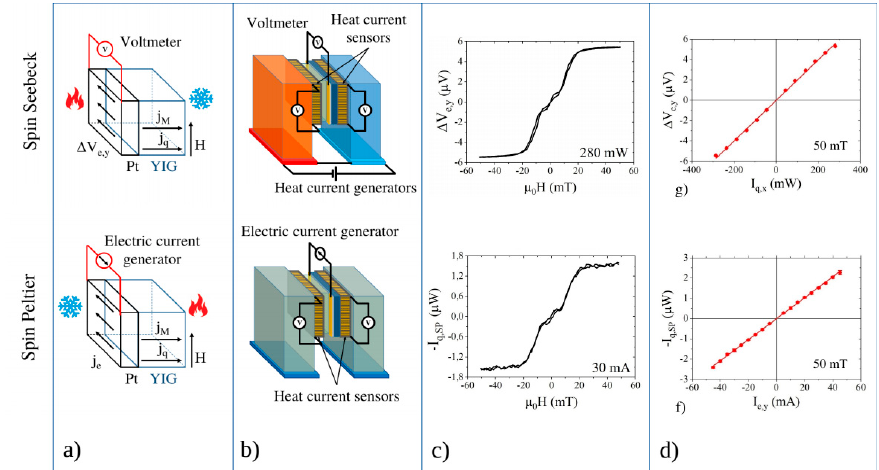
Figure 1. SSE and SPE heat-current-based measurements. ( a ) Schemes of the YIG-Pt device. ( b ) Sketches of the experimental setups. ( c ) Examples of SSE and SPE hysteresis loops. ( d ) Results at magnetic saturation of the SSE voltage as function of the heat current and SPE heat current as function of the electric